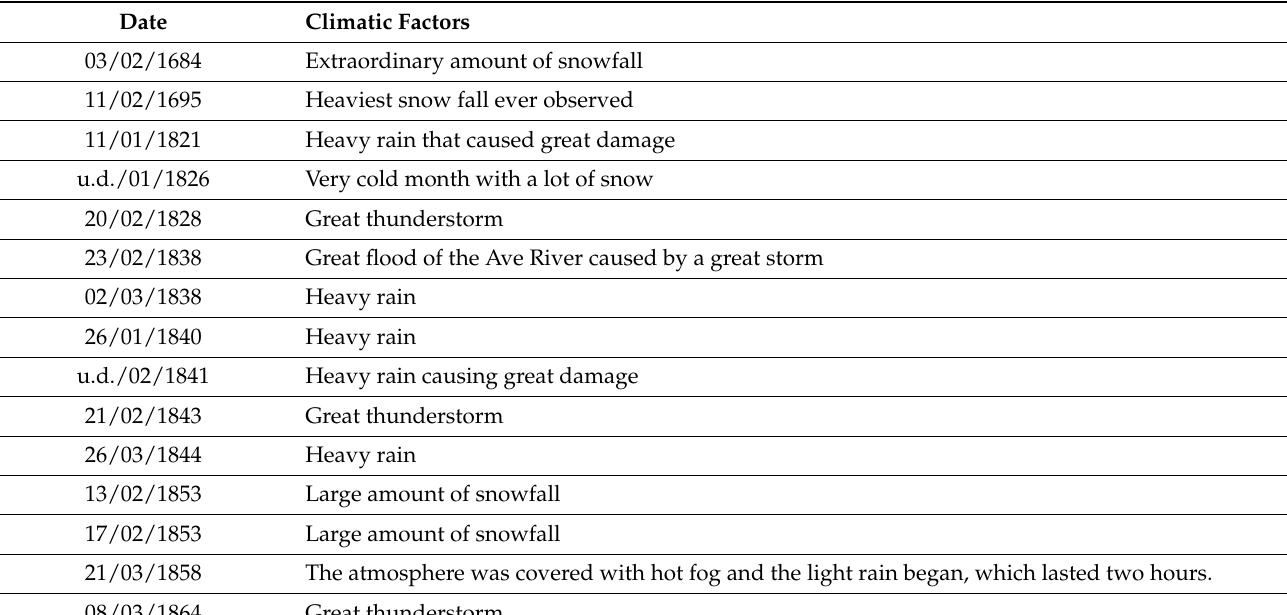
Table 6. Records related to climatic factors collected by Jo ã o Lopes de Faria in the work “ Efem é rides Vimaranenses ” (u.d.: unknown